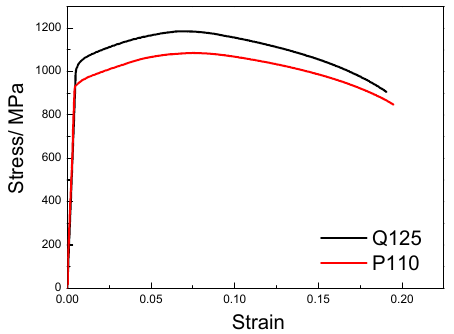
Figure 1. True stress–strain curves of P110 and Q125 casings.